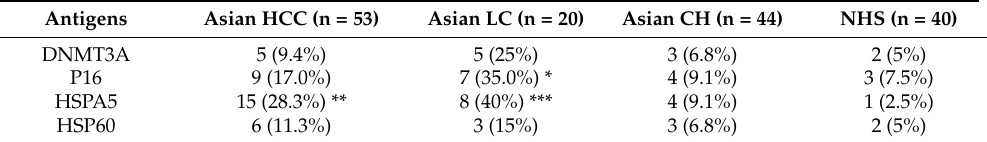
Table 5. Frequency of the four anti-TAA autoantibodies in Asian sera cohort.